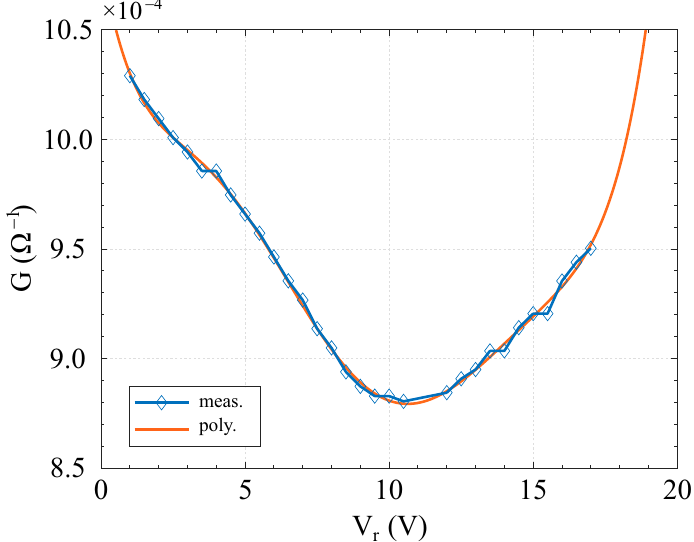
Figure 14. Values of nonlinear conductance G ( V r ) exhibited by the filter when control voltage V r was equal to 10